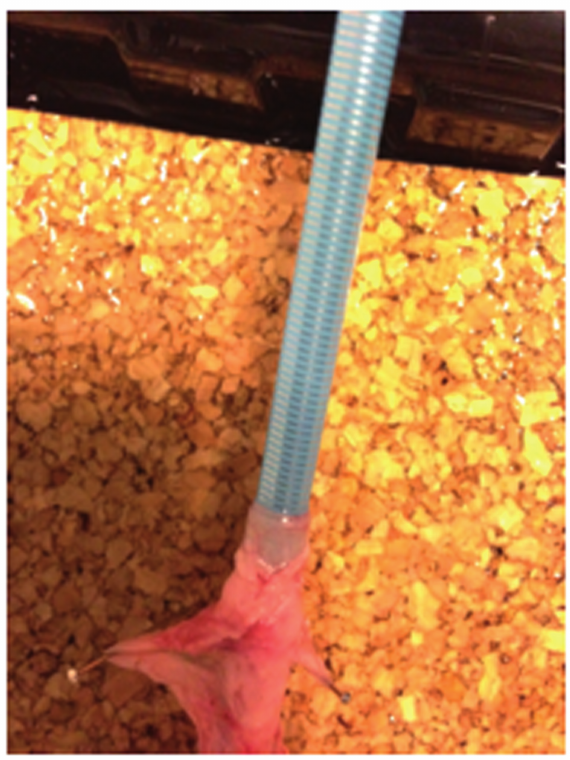
figure 7 - pig Ureteral Avulsion with Extraction of